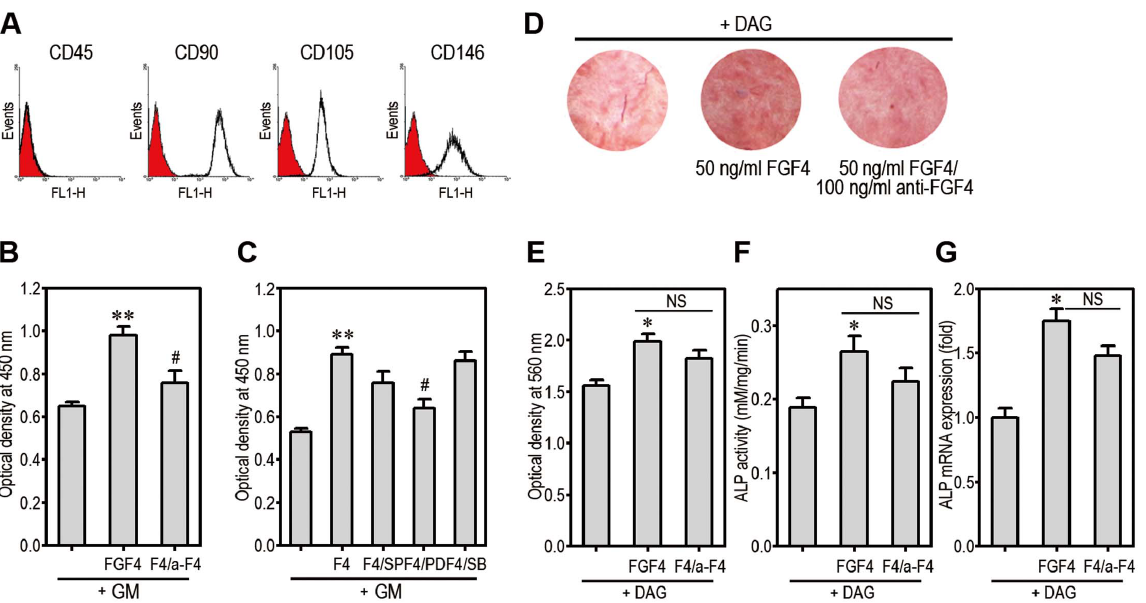
Figure 8. FGF4 stimulates proliferation and mineralization of hPDLSCs. (A) hPDLSCs at passage 3 were labeled with the indicated primary antibodies and then analyzed by flow cytometer. The cells were incubated for 48 h with 50 ng/ml FGF4 and/or 100 ng/ml (B), or with each of MAPK inhibitors (C) in 96-multiwell plates. The cells were processed for cell proliferation assay. **p , 0.01 vs. GM alone. # p , 0.05 vs. FGF4 treatment alone. (D) hPDLSCs were incubated in the presence of DAG with and without 50 ng/ml FGF4 and 100 ng/ml anti-FGF4 for 14 days and then were processed for Alizarin red staining. (E) Absorbance of the dye was determined at 560 nm. hPDLSCs were also processed for analysis of ALP activity (F) and mRNA expression (G) after 5 days of differentiation. *p , 0.05 vs. DAG alone. F4, FGF4; GM, growth medium; NC, non-significant.